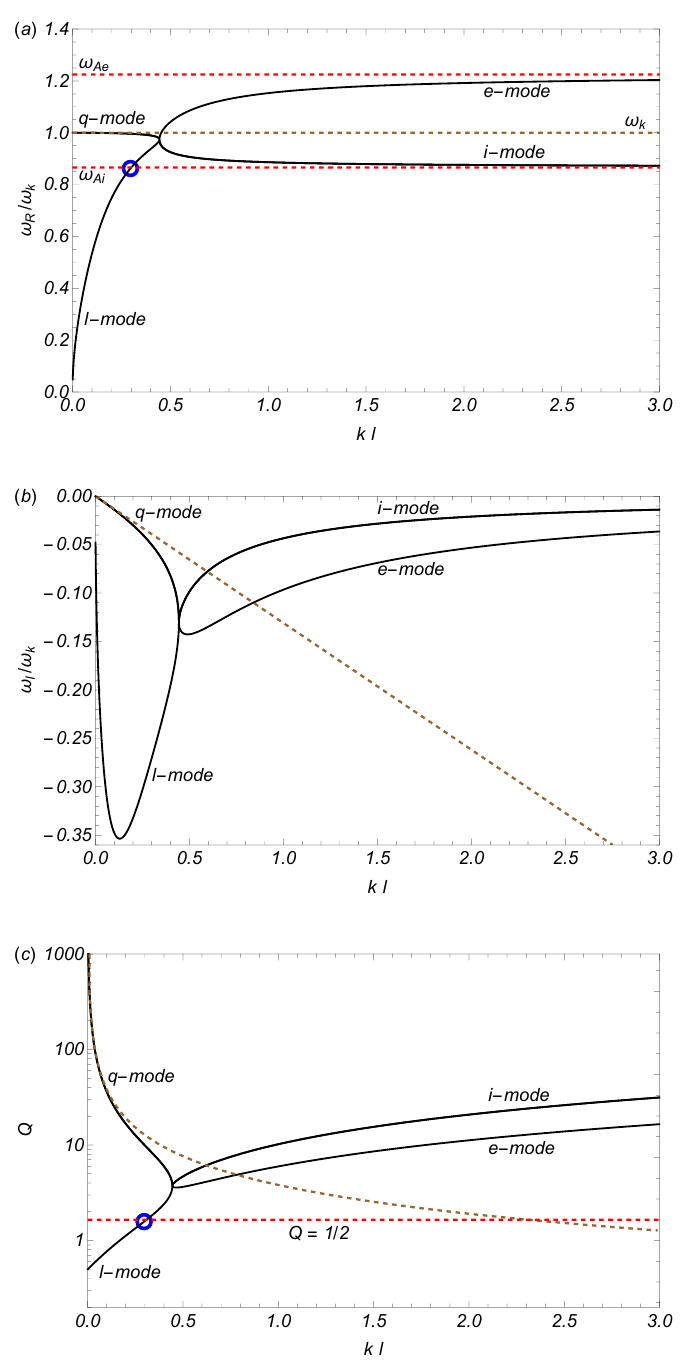
Figure 1. Real part ( a ), imaginary part ( b ), and quality factor ( c ) of the solutions versus kl . The solid lines are the numerical results of the dispersion relation (Equation (17)), and the dashed brown lines are the analytic results for thin transitions (Equations (28) and (29)). The two horizontal dashed red lines in panel ( a ) denote ω A,i and ω A,e . The horizontal dashed red line in panel ( c ) denotes Q = 1/2. The blue circles in panels ( a , c ) mark the entering of the l -mode in the Alfvén continuum. Frequencies are normalized to ω k . ρ i / ρ e = 2, kL = 1, and k z L = 0.1 are used here, where L is a normalization